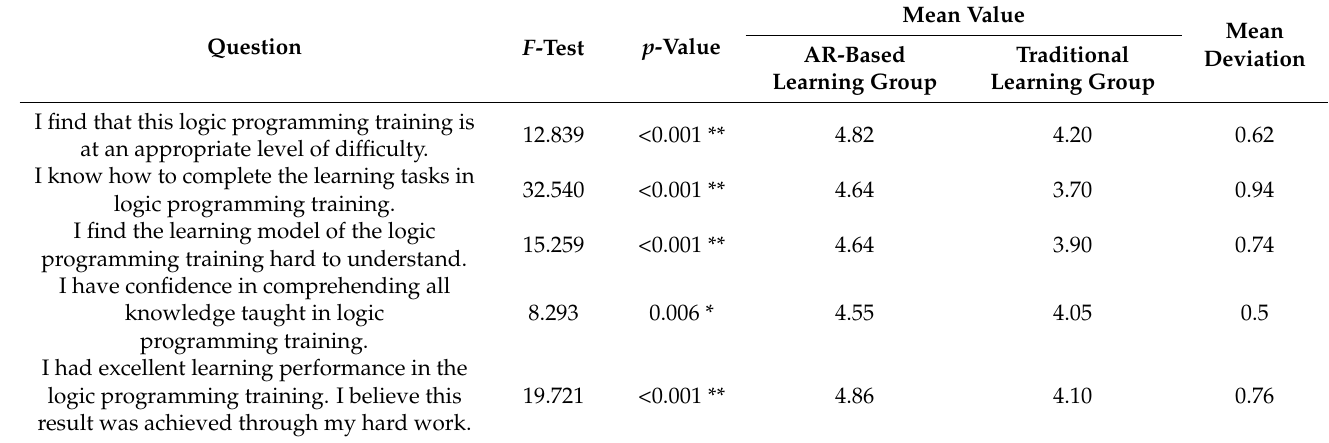
Table 11. Level of significance for each question in the Confidence